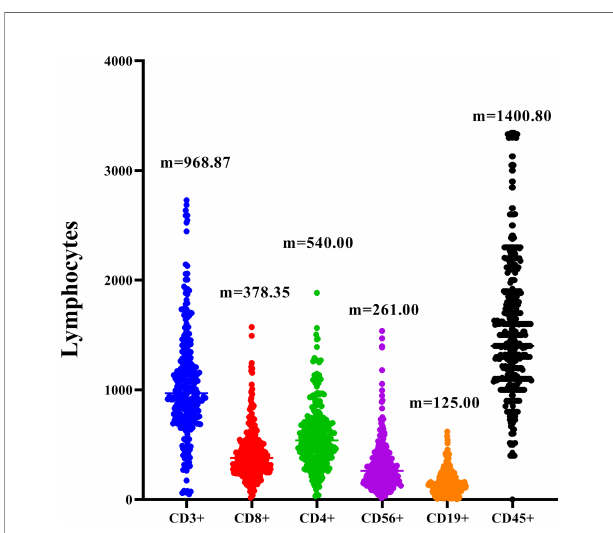
FIGURE 1 | Distribution of peripheral blood CD3+, CD8+, CD4+, CD19+, CD45+ and CD56+ in TNBC. M is the median of each lymphocyte subpopulation.